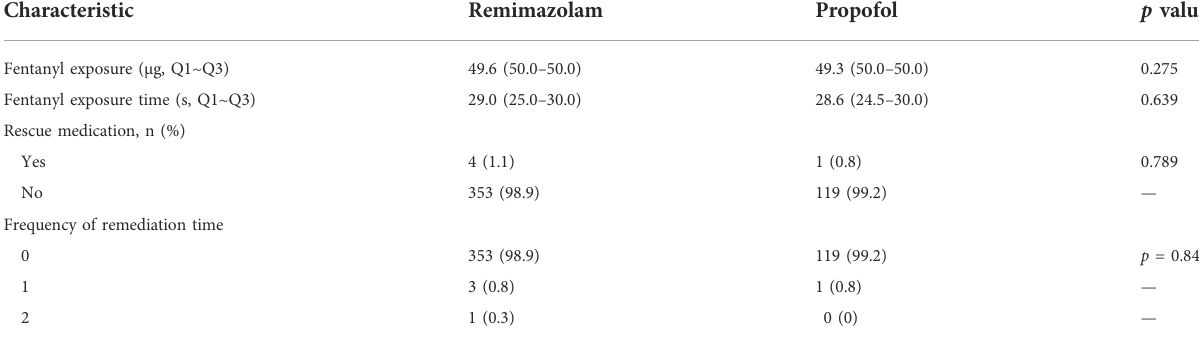
TABLE 4 Fentanyl exposure and rescue